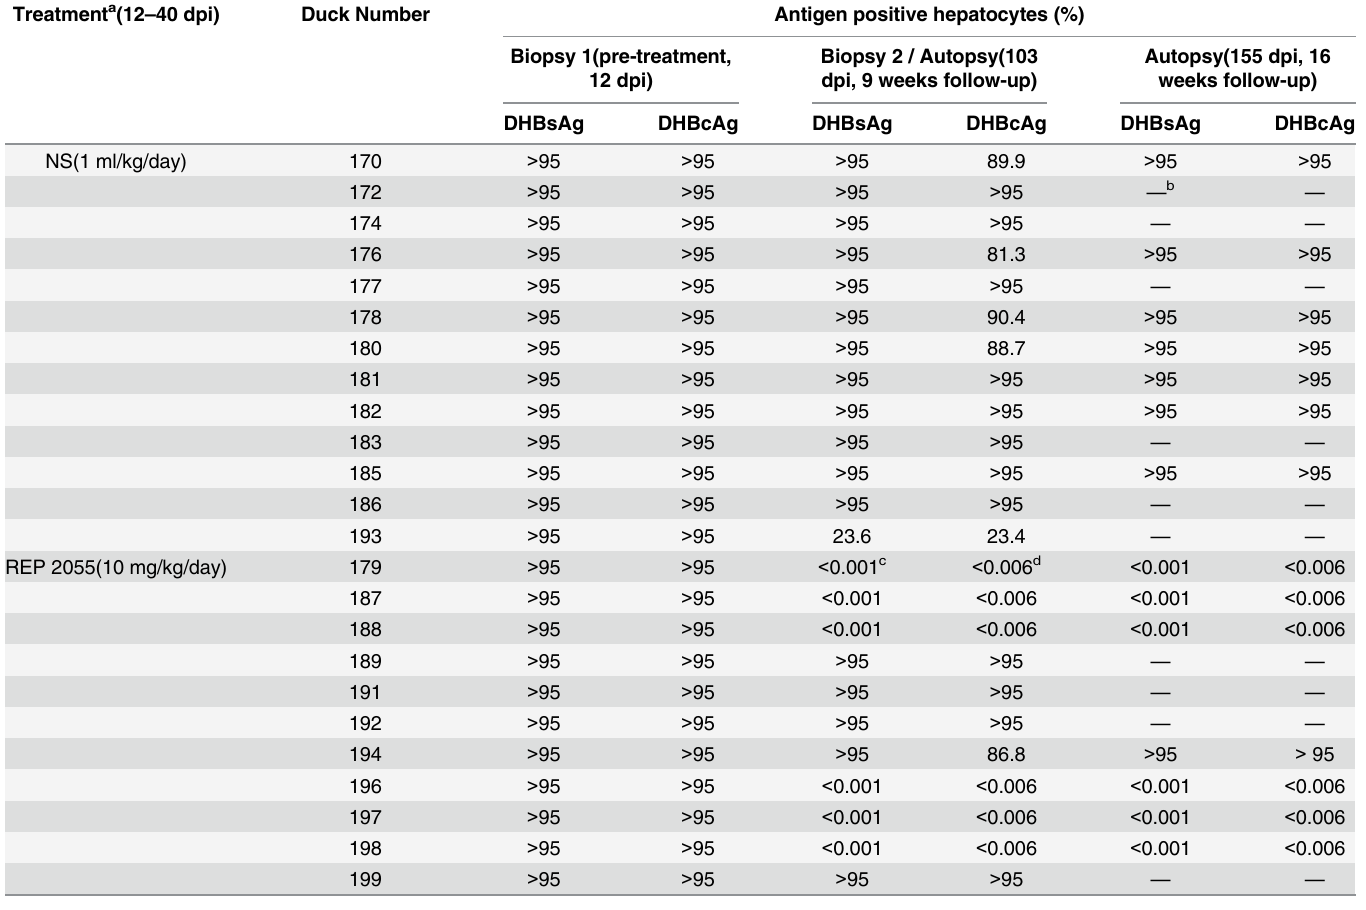
Table 2. In vivo Experiment 2: Detection of DHBsAg and DHBcAg positive hepatocytes in liver tissue. Treatment a (12 – 40 dpi)